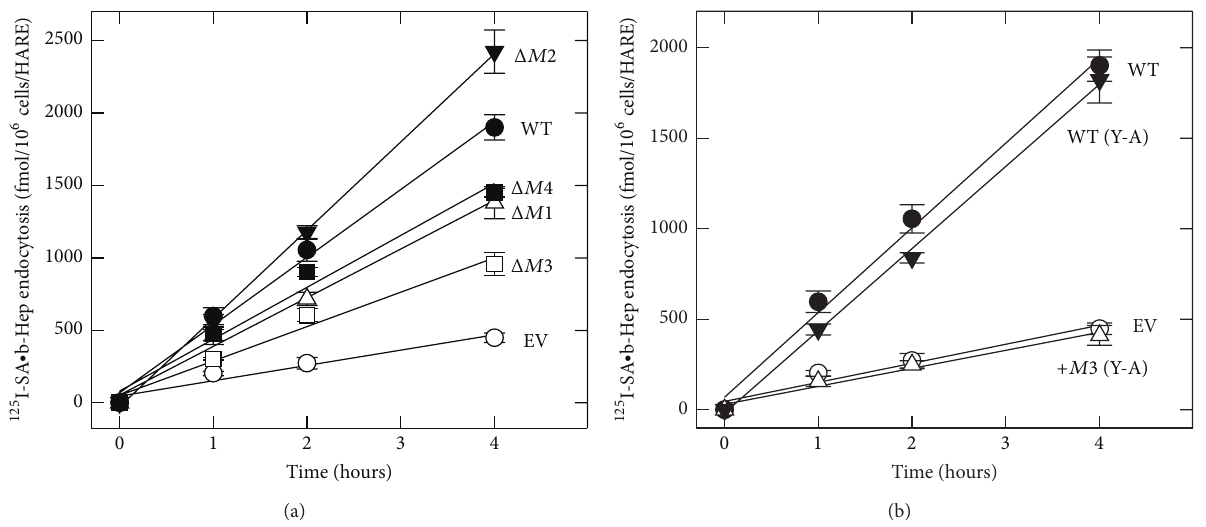
Figure 3: Hep endocytosis by cells expressing WT or HARE CD variants. Cells expressing WT ( e ), EV ( I ), or HARE CD mutants ((a) Δ M1 ( Δ ), Δ M2 ( 󳶃 ), Δ M3 ( ◻ ), and Δ M4 ( ◼ ) and (b) + M3 (Y2519A) ( Δ ), and WT (Y2519A) ( 󳶃 )) were pretreated and incubated with 125 I-SA ∙ b-Hep complexes at 37 ∘ C as in Figure 2 for the indicated times to assess uptake rates as described in Methods section. Values are means ± SE ( 𝑛 = 9 ) and all linear regression lines had correlation coefficients ≥